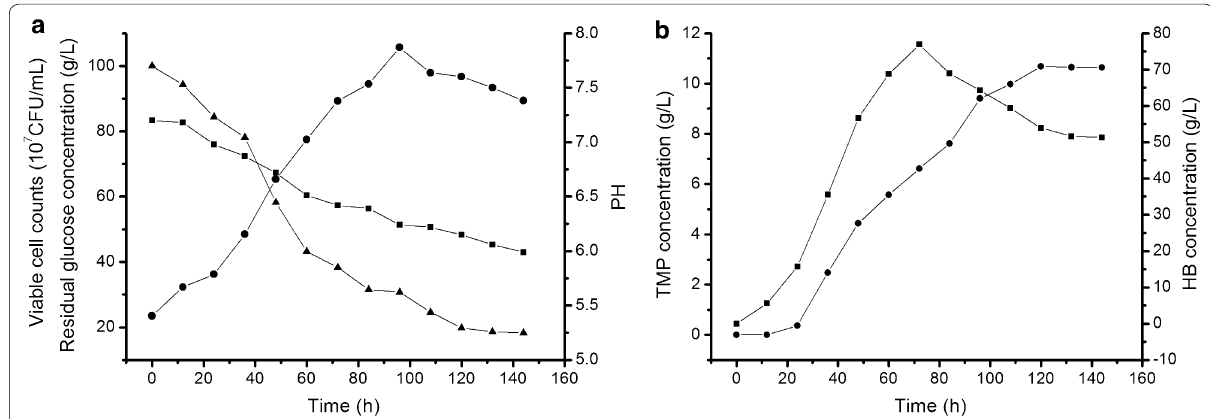
Fig. 7 The fermentation process curve of LB5. Viable cells counts, residual glucose, PH value, the content of TMP and HB in the fermentation broth of LB5 were detected every 12 h a time till 144 h. a Black circle viable cells, black up-pointing triangle residual sugar content, black square PH value. b black square HB, black circle